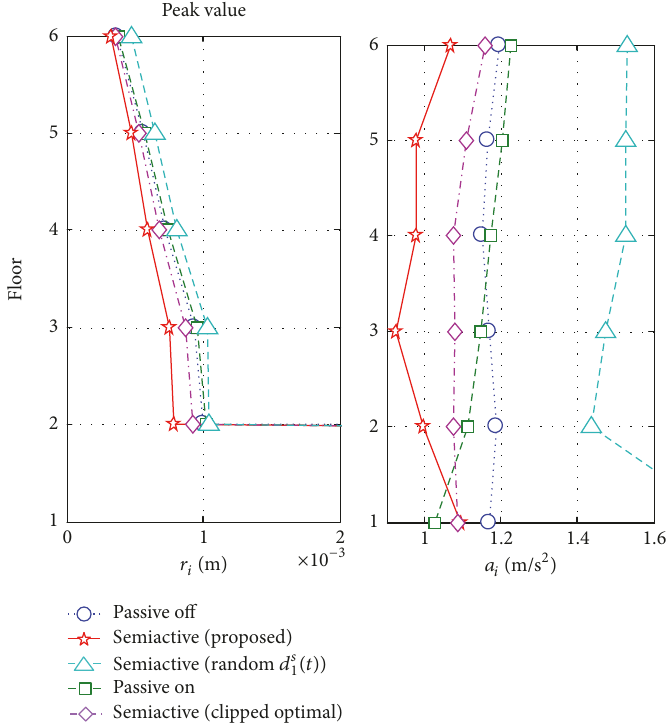
Figure 23: Simulation results for the Akita NS (1983) earthquake disturbance; peak values of the relative displacement between neighboring floors and absolute acceleration of each